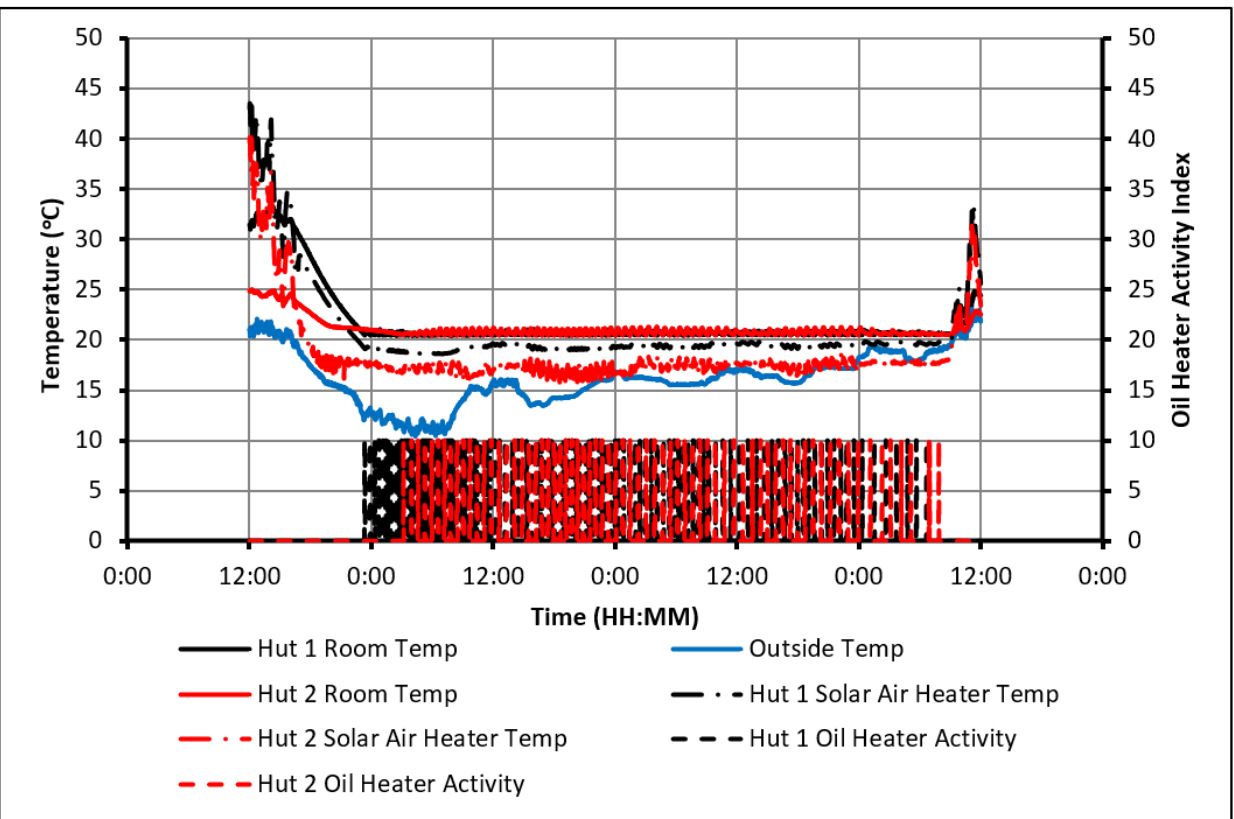
Figure 9. Temperature profiles and heater activity (20 – 22 °C temp constraints, days 12 – 15).